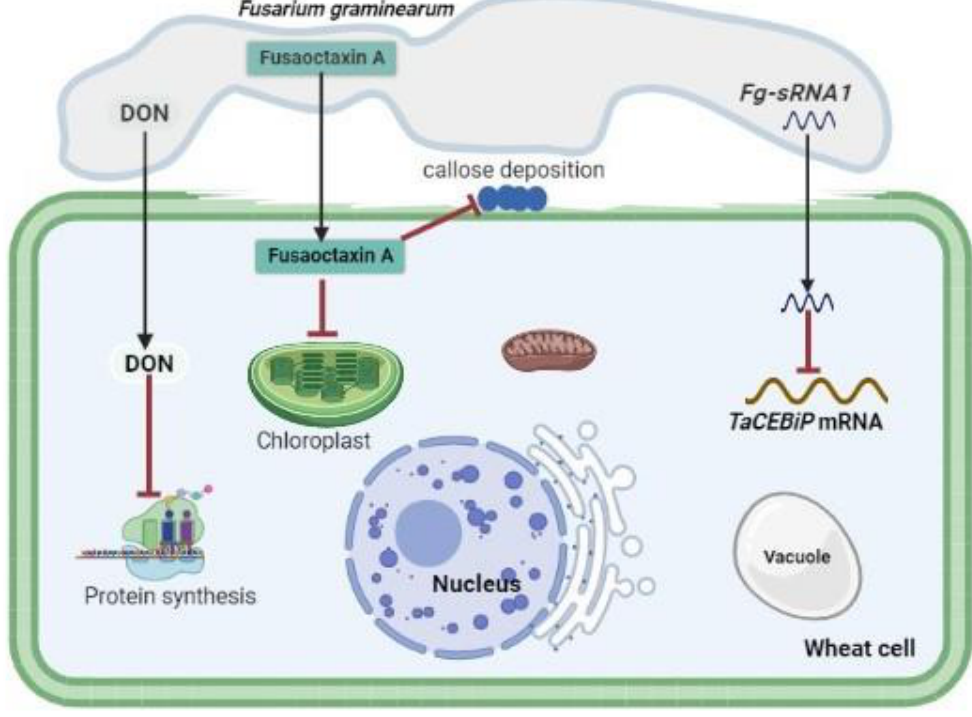
Figure 3. Mode of action of F. graminearum -secreted pathogenicity factors during F . graminearum - wheat interaction. The sRNA effector Fg -sRNA1 contributes to virulence by silencing wheat defense-related TaCEBiP . Fungal toxin DON inhibits protein biosynthesis by binding to the ribosome. The fungal toxin Fusaoctaxin A changes the subcellular localization of chloroplasts in the coleoptile cells and prevents callose accumulation in plasmodesmata during pathogen infection, facilitating the cell-to-cell invasion of F. graminearum in wheat tissues.